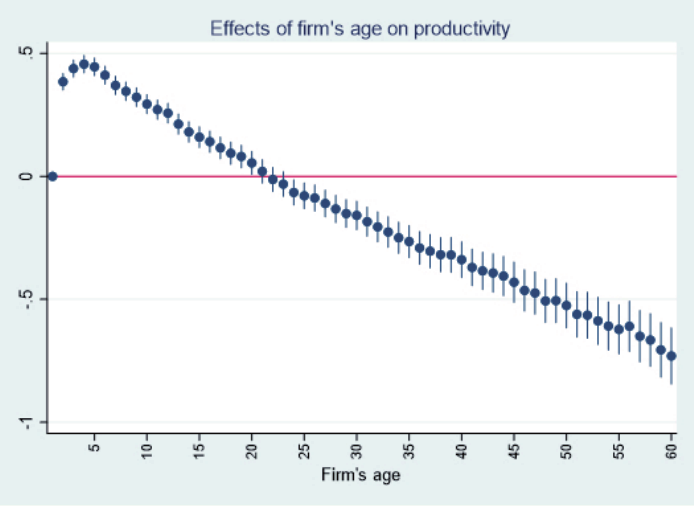
Fig. 1 – The effects of age of firm (categorised) on Total Factor Productivity. Source: own